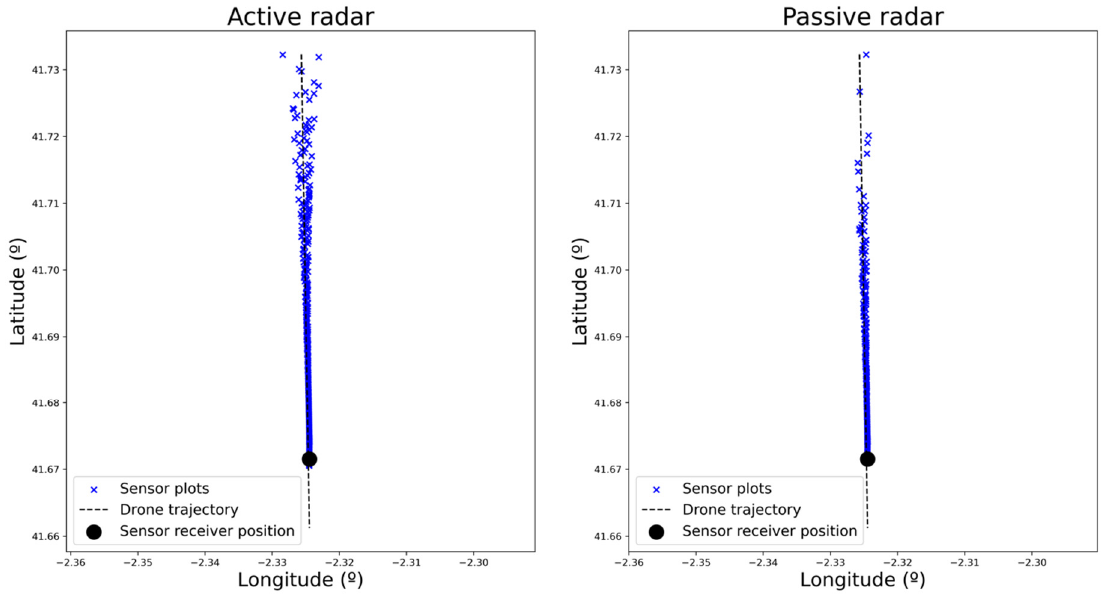
Figure 5. Plots generated by the active and passive radar sensors corresponding to the actual incoming drone.